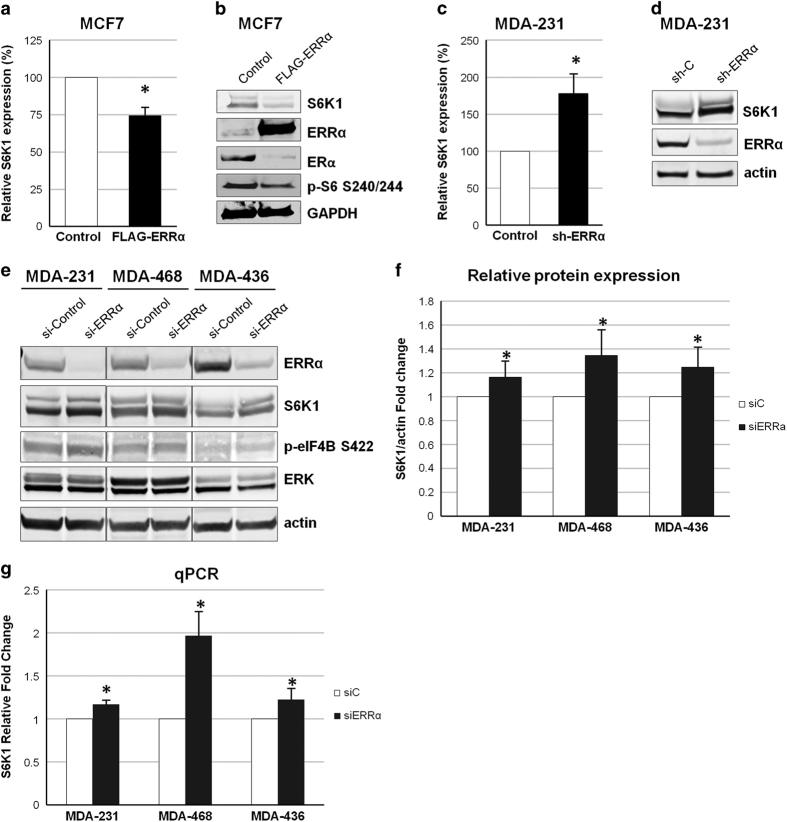
ERRα regulates S6K1 expression in ERα-positive and ERα-negative cells. (a) MCF7 cells were transfected with FLAG-ERRα. Forty-eight hours following transfection, cells were lysed and mRNA was prepared and analyzed for S6K1 expression using RT-qPCR as described in ‘Materials and Methods’ section. Statistical analysis was performed using paired Student’s t-test. * represents P<0.05. (b) Cells were transfected as in a and analyzed for expression of S6K1, ERRα, ERα and p-S6 S240/244 by immunoblotting. Anti-GAPDH antibody was used as loading control. (c) Stable MDA-MB-231 control or ERRα knockdown cells were analyzed for S6K1 expression using RT-qPCR. Statistical analysis was performed using paired Student’s t-test. * represents P <0.05. (d) Stable MDA-MB-231 control or ERRα knockdown cells were lysed and analyzed using the indicated antibodies. (e) MDA-MB-231, -468 or -436 cells were transfected with siRNA against ERRα or scrambled control. Forty-eight hours following transfection, cells were lysed and probed with the indicated antibodies. (f) Cells were treated as in e and relative S6K1 protein levels were measured using Odyssey Image Studio Ver5.2 software. Statistical analysis was performed using paired Student’s t-test. * represents P⩽0.05. (g) MDA-MB-231, -468 or -436 cells were treated as in e and analyzed for S6K1 mRNA expression using RT-qPCR. Statistical analysis was performed using paired Student’s t-test. * represents P<0.05.